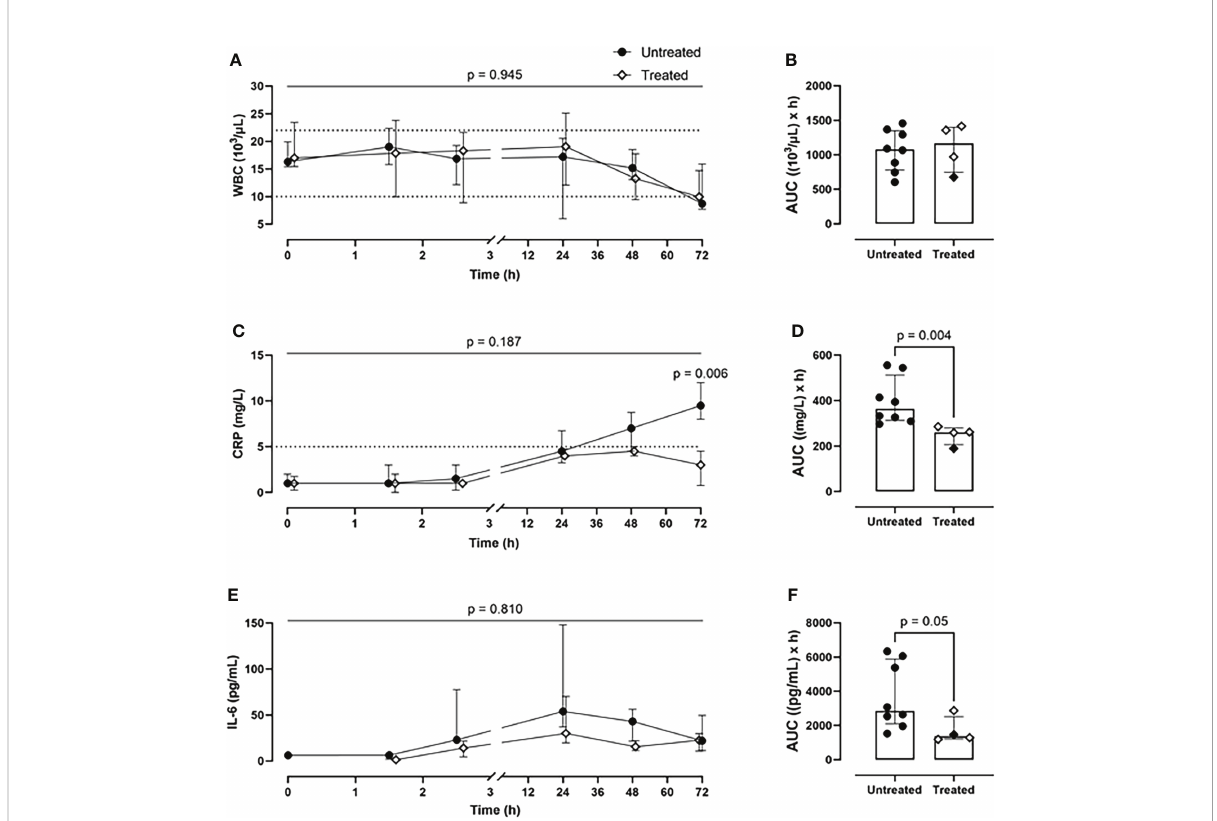
FIGURE 4 Systemic in fl ammatory parameters. (A) WBCs monitoring and (B) WBCs AUC analysis showed no difference between the two groups. (C) CRP monitoring and (D) CRP AUC analysis revealed a signi fi cant reduction of CRP values in blood in the treated group (n=4), compared to the untreated group (n=8). (E) IL-6 monitoring and (F) IL-6 AUC analysis showed a diminished IL-6 expression in the treated group (n=4), compared to the untreated group (n=8). Dotted lines represent the normal reference range. Overall p-value for group comparison of treated vs. untreated animals over time is displayed above the summary trajectories. In the AUC graphical representation, the fi rst pig, receiving lower inhibitor dosage, is represented as black fi lled